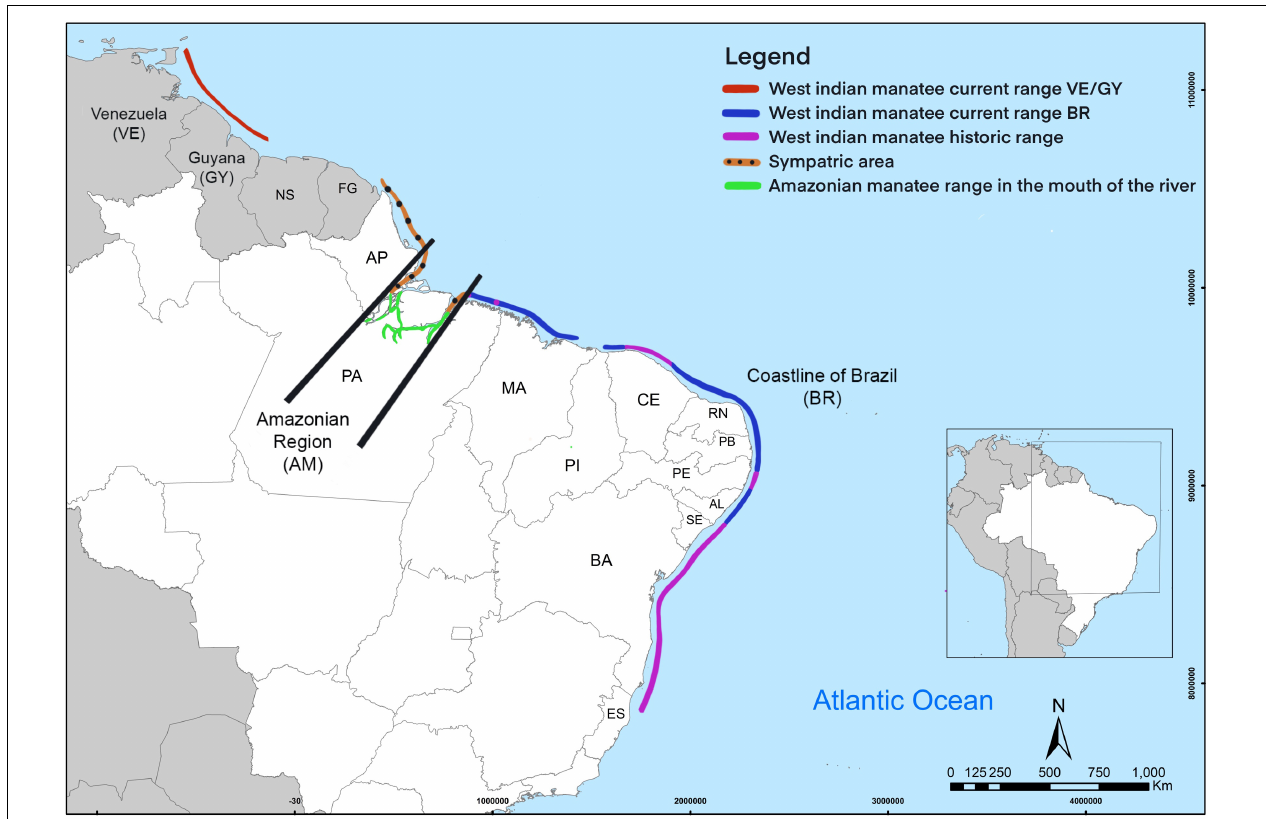
FIGURE 1 | Map of the sample area and the geographic extent of the genetic groupings. Genetic groupings are labeled accordingly and abbreviations are identified. The black bars indicate approximate geographic separation. State and country names are abbreviated for simplicity (see main text for abbreviations). Historic areas of Brazilian distribution are also